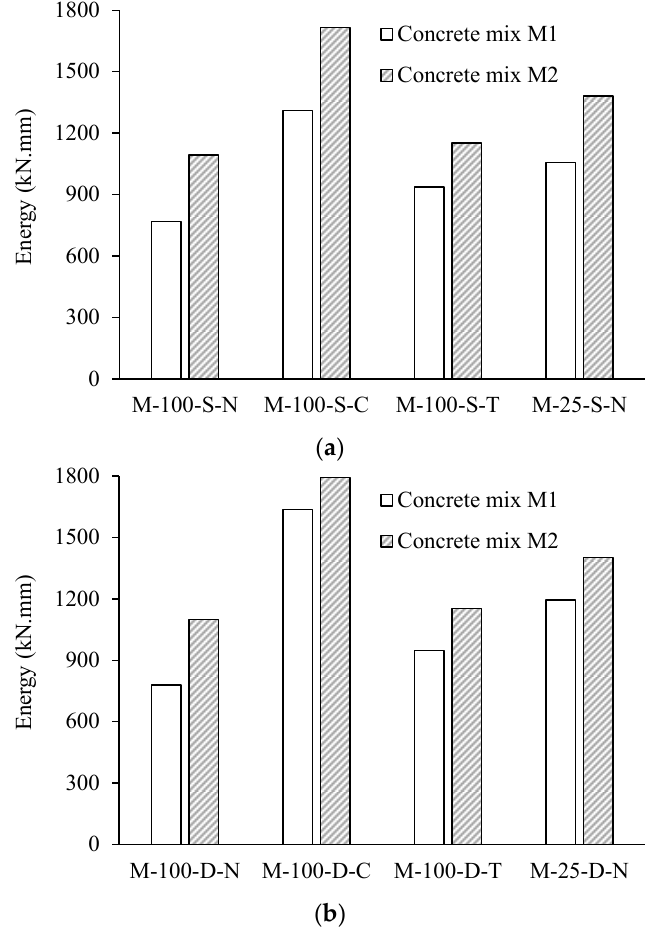
Figure 7. Results of quantitative analysis of the energy absorbed during quasi-static punching of concrete slabs: ( a ) singly reinforced and ( b ) doubly reinforced.